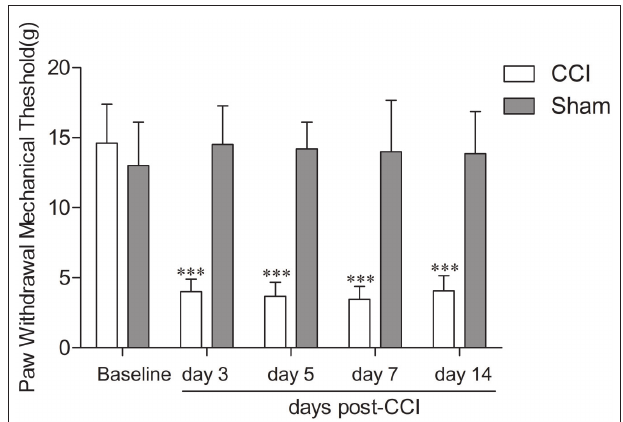
FIGURE 1 | Chronic constriction injury (CCI)-induced mechanical allodynia in rats. CCI resulted in a significant decrease in paw withdrawal threshold in response to mechanical stimulation of the injury on the paw side on day 3, 5, 7, and 14 post surgery in rats ( n = 8); *** P < 0.001, compared with the baseline and sham group ( n = 8). Sham surgery did not cause mechanical hypersensitivity ( n = 8; P >